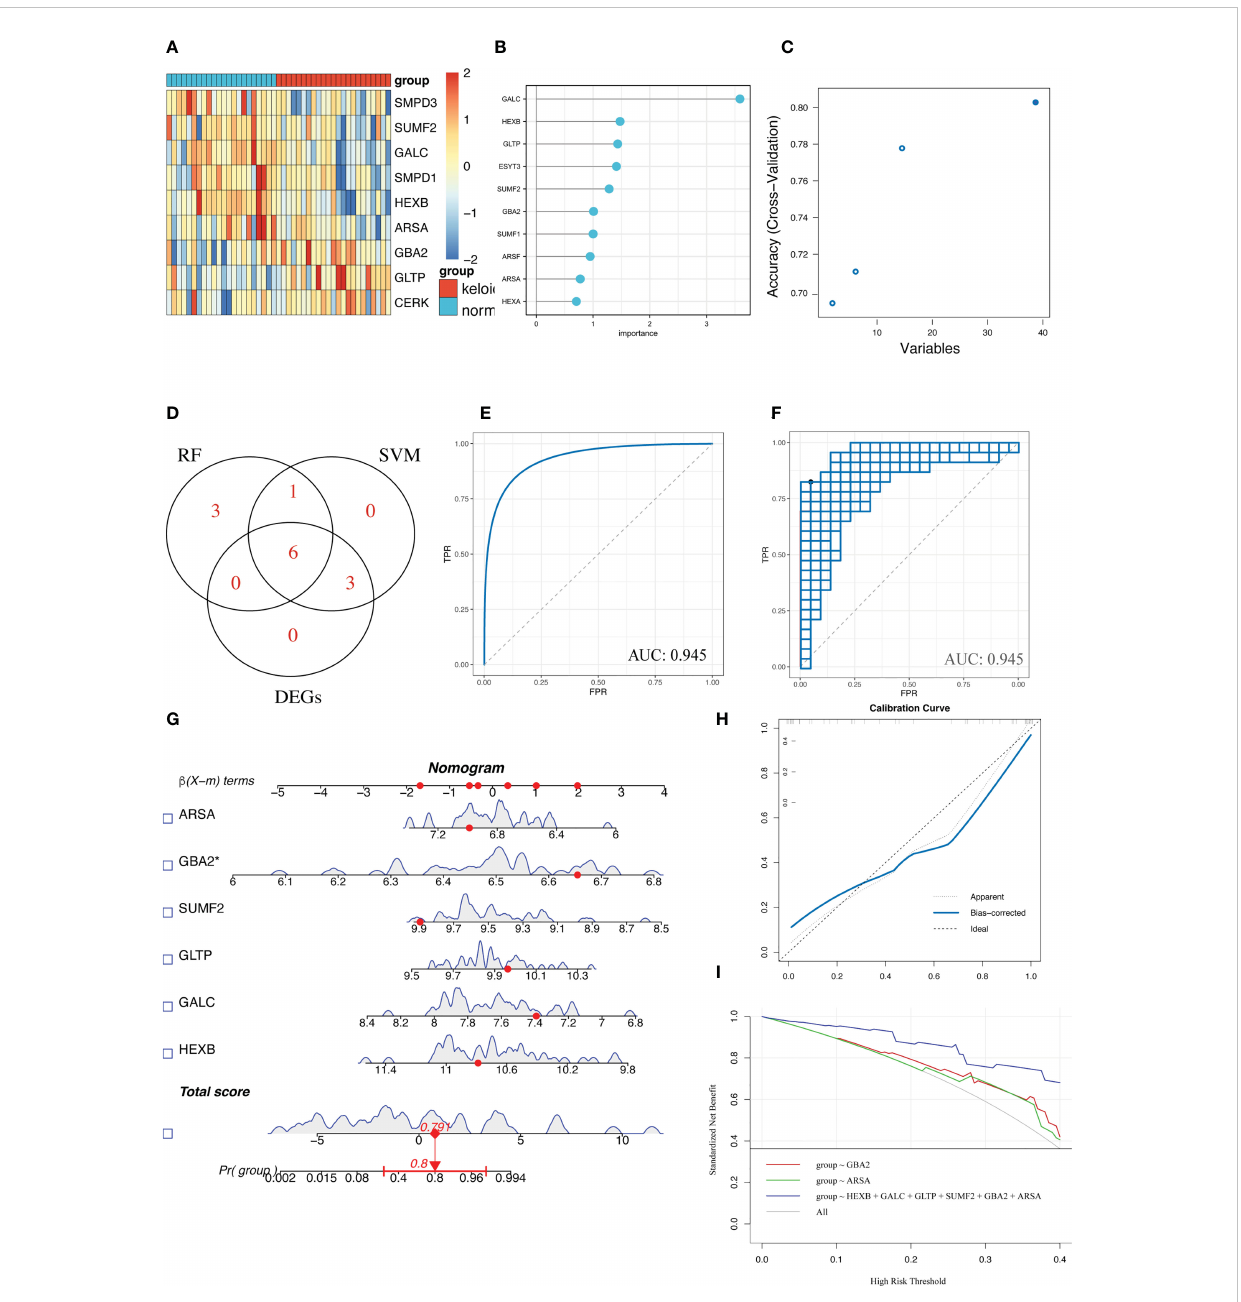
FIGURE 3 Diagnostic model of keloid was constructed and evaluated. (A) Heatmap for differential analysis of GSLERGs between keloid and normal samples. (B) Random forest algorithm screening for gene importance ranking. (C) SVM-REF algorithm screening for genes. (D) Venn plot showed the intersection genes of the top 10 of RF, SVM-REF and DEGs. (E) ROC curves under AUC values in the diagnostic model built using the 6 GSLERG. (F) Bootstrap resampling algorithm to validate the model. (G) Keloid prediction by nomogram. (H) Calibration curve to evaluate the nomogram. (I) Decision curves to assess the predictive performance of the